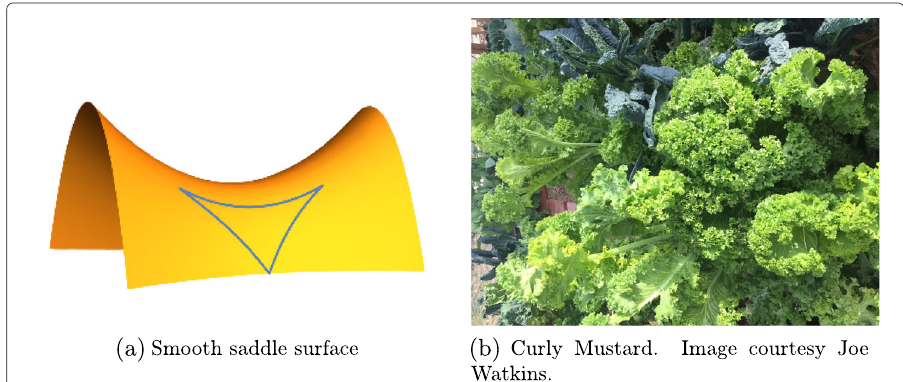
Fig. 3 Hyperbolic surfaces in R 3 . The inscribed (geodesic) triangle in the smooth saddle has angles that sum up to less than π , illustrating the connection between the extrinsic and intrinsic geometries – Gauss’ Theorema